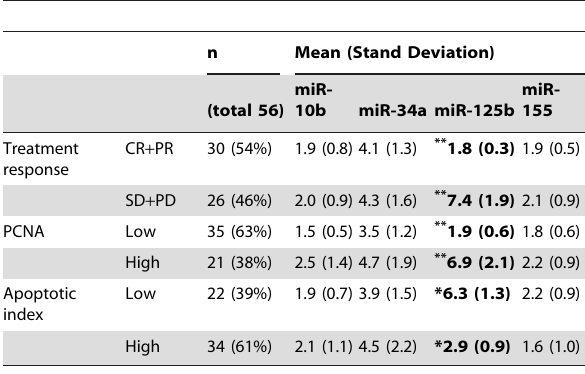
Table 2 Correlation of serum miRNA levels and response to